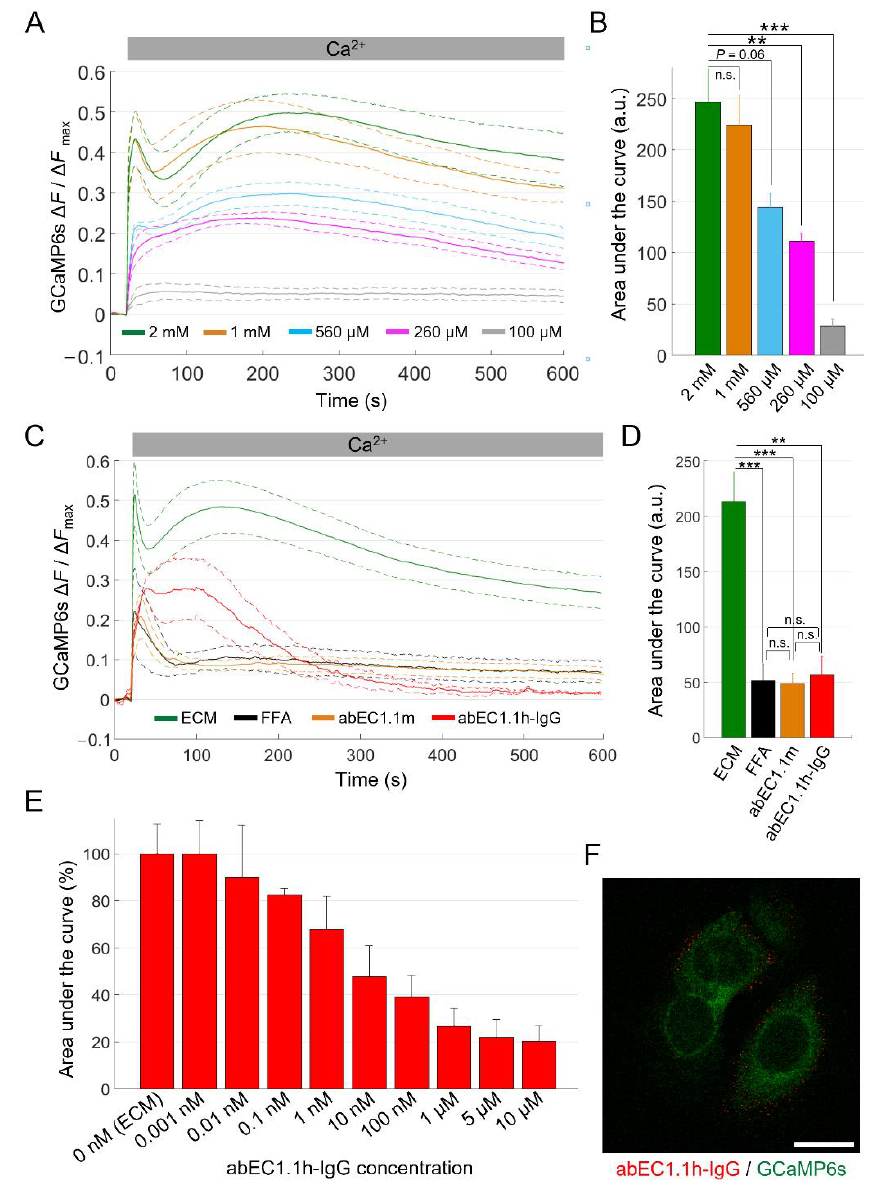
Figure 4. Ca 2+ uptake in HaCaT-Cx26-GCaMP6s cells. ( A ) The mean Ca 2+ uptake traces (solid lines) ± s.e.m. (dashed lines) obtained in HaCaT-Cx26-GCaMP6s cell cultures bathed in ECM and exposed to different CaCl 2 bolus concentrations (BCs) to reach the following final [Ca 2+ ] ex : 2 mM (green, n = 5, BC = 1 M), 1 mM (orange, n = 5, BC = 500 mM), 560 µM (light blue, n = 4, BC = 250 mM), 260 µM (magenta, n = 4, BC = 100 mM) and 100 µM (grey, n = 4, BC = 20 mM). Time t = 0 marks the onset of image acquisition. ( B ) Quantification of cytosolic Ca 2+ load for the results in ( A ) computed as the areas subtended by the normalized Ca 2+ uptake traces in the time interval between t = 20 s and t = 590 s (data are quoted as the mean ± s.e.m). Statistical significance was calculated using the Bonferroni post hoc test for pairwise comparisons after the ANOVA test; n.s., not significant; P , p -value; **, P < 0.01; ***, P < 0.001. ( C ) The mean Ca 2+ uptake responses (solid lines) ± s.e.m. (dashed lines) to a 1 M CaCl 2 bolus obtained from HaCaT-Cx26-GCaMP6s cell cultures bathed in the following extracellular media: ECM (green, n = 8), ECM plus FFA (100 µM, black, n = 4), ECM plus abEC1.1m (1 µM, orange, n = 7) and ECM plus abEC1.1h-IgG (1 µM, red, n = 3). ( D ) Quantification of cytosolic Ca 2+ load for the results in ( C ) computed as described in ( B ). ( E ) Dose-dependent effect of the abEC1.1h-IgG for concentrations in the range 0.001 nM – 10 µM (data are quoted as the mean ± s.e.m. for each condition). ( F ) Immunofluorescence labeling of HaCaT-Cx26-GCaMP6s cells with abEC1.1h-IgG; the antibody (15 nM) was applied to live cells that were then fixed but not